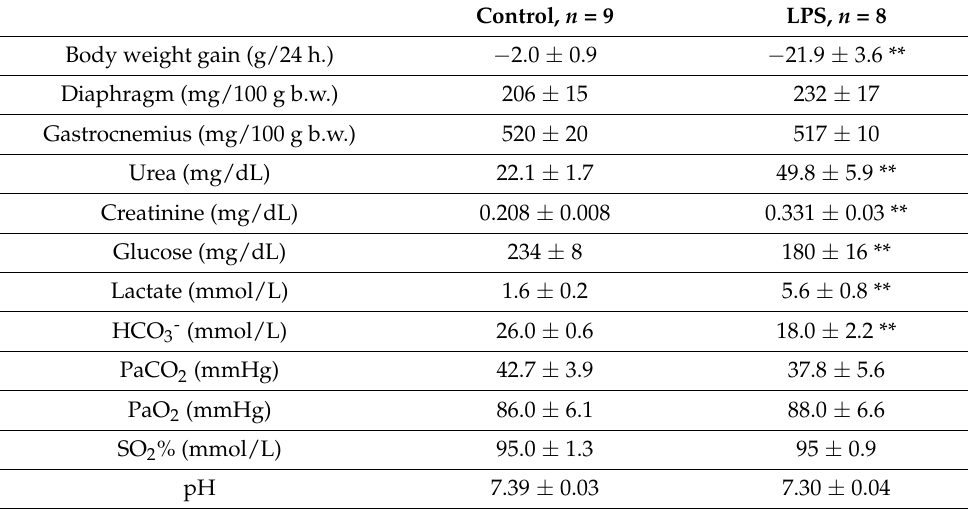
Table 1. Effect of lipopolysaccharide (LPS) administration (10 mg/kg ip.) on body weight gain, diaphragm and gastrocnemius weights, serum concentrations of urea, creatinine, glucose, lactate, bicarbonate (HCO 3 − ) , partial pressure of carbon dioxide oxygen (PaCO 2 ), oxygen (PaO 2 ), and soluble oxygen SO 2 and pH in arterial blood. The data represent mean ± standard error of the mean (SEM). ** p < 0.01 versus control rats treated with saline. Control, n = 9 LPS, n = 8 Body weight gain (g/24